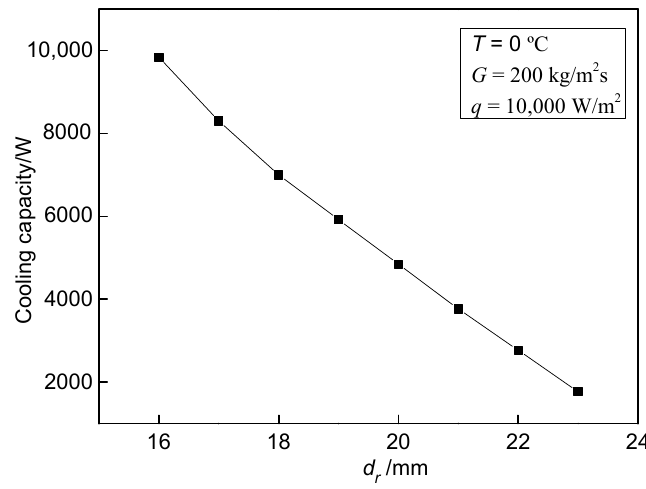
Figure 12. Effect of d r on cooling capacity.